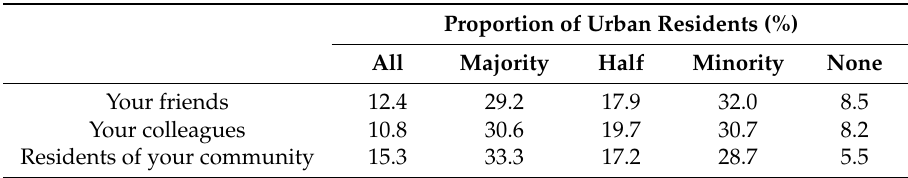
Table 3. The social circle composition of migrant